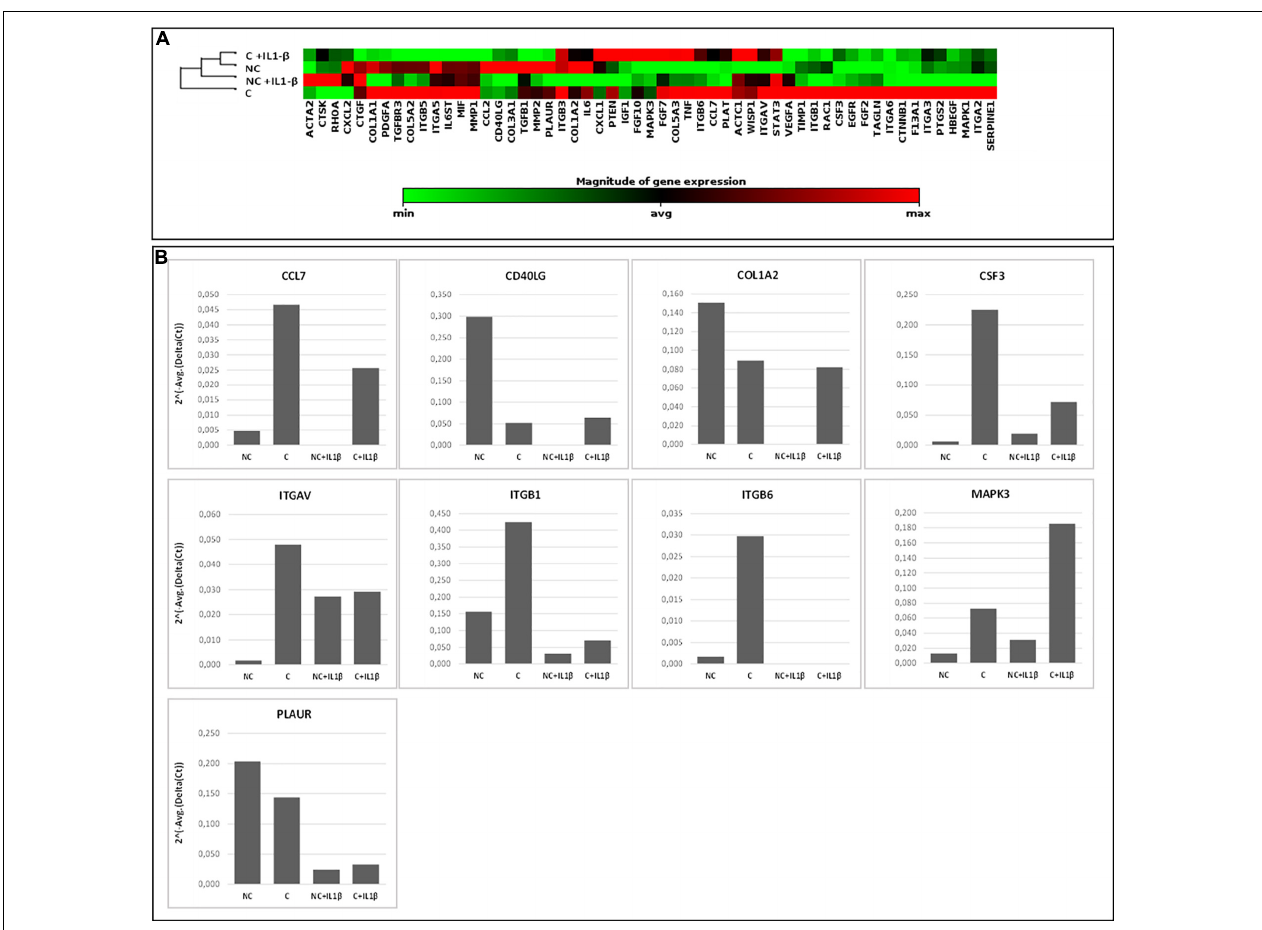
FIGURE 6 | Array-based gene expression analysis of OA cartilage samples. A focused panel of 84 genes involved in wound healing was analyzed. Four experimental conditions were tested: (1) NC (not compressed cartilage, control group); (2) C (compressed cartilage); (3) NC+IL1- β (not compressed cartilage stimulated with the pro-inflammatory factor IL1- β ); and (4) C+IL1- β (compressed cartilage stimulated with the pro-inflammatory factor IL1- β ). Each group consists of two samples from two different donors. (A) Heatmap of the unsupervised hierarchical cluster analysis. Red indicates high levels of expression and green indicates low levels of expression; (B) Variations of selected genes after OA cartilage compression for 45 min at 1 Hz and 3 MPa and with addition of pro-inflammatory stimulation (IL1- β 2 ng/ml). Genes with a fold change of at least 5 in one out of 4 conditions are